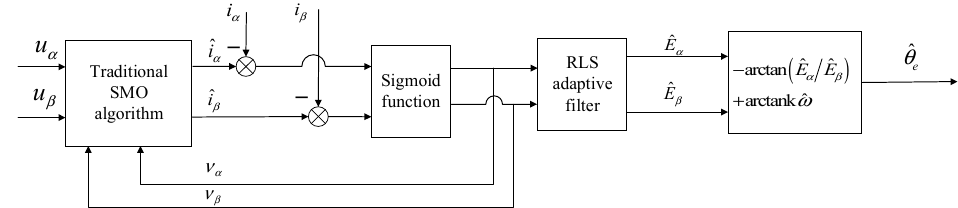
Figure 8. Principle block diagram of the new improved SMO algorithm.